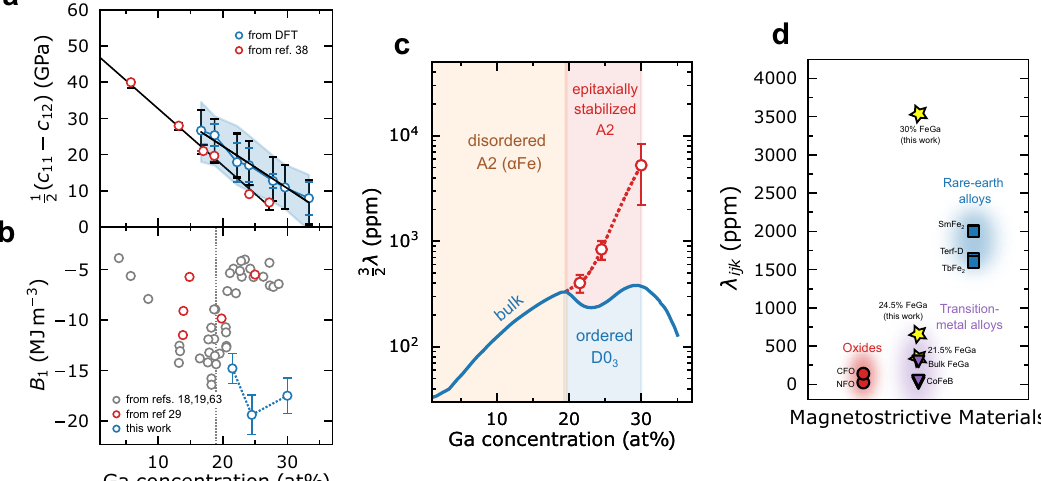
(cid:4) (cid:5) c (cid:6) c extracted from literature (red) Fig. 4 Enhanced magnetostriction coef fi cient through epitaxial stabilization. a Plot of mechanical coef fi cient 1 11 12 2 and simulated here with DFT (blue). Both data sets follow approximately the same trend and show no deviation from linear behavior following the ~19% phase limit. The blue error bars correspond to the error of the calculation, the black error bars are one standard error of the linear fi t, and the shaded area is the sum of the errors fi xed about the trendline. Literature values are from ref. 39 . b Plot of magnetoelastic coef fi cients ( B 1 ) taken from the previous thin fi lm (red) and bulk (gray) works compared to our measured values. We note that in previous work, there is a sharp decline in B 1 following the phase change at ~19% Ga (dotted line), which we do not observe. Bulk (gray) values are from refs. 18,19,63 and fi lm (red) values are from ref. 30 . c The extracted magnetostriction values as a function of Ga concentration with our values (red, open circles) compared to the measured bulk coef fi cients (blue) from λ ref. 19 . The values from this work are plotted as 3 100 to facilitate comparison with the bulk, polycrystalline values. Above 19% Ga, we do not observe a 2 decrease in the magnetostriction associated with the formation of the ordered D0 3 phase and we extend the regime of the disordered A2 phase via epitaxial stabilization 21 . As the concentration approaches the second phase change at ~30% Ga, the shear modulus c 11 (cid:6) c 12 approaches 0, leading to extremely large values of the magnetostriction. Calculation of the error bars, σ λ , is detailed in Sup. Note 4. d Comparison of the magnetostriction coef fi cients from this work to other magnetostrictive materials. The largest magnetostrictive tensor component λ ijk of each respective material is plotted here for ease of comparison. Comparative data in ( b ) from refs. 54 – 62